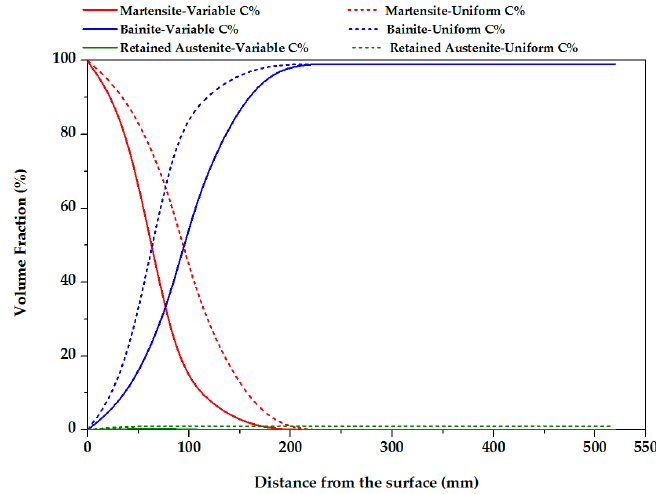
Figure 6. Effect of carbon concentration on the predicted phase distribution along the depth of the block after water-quenching process. Dashed line condition (A); Solid line condition (B).